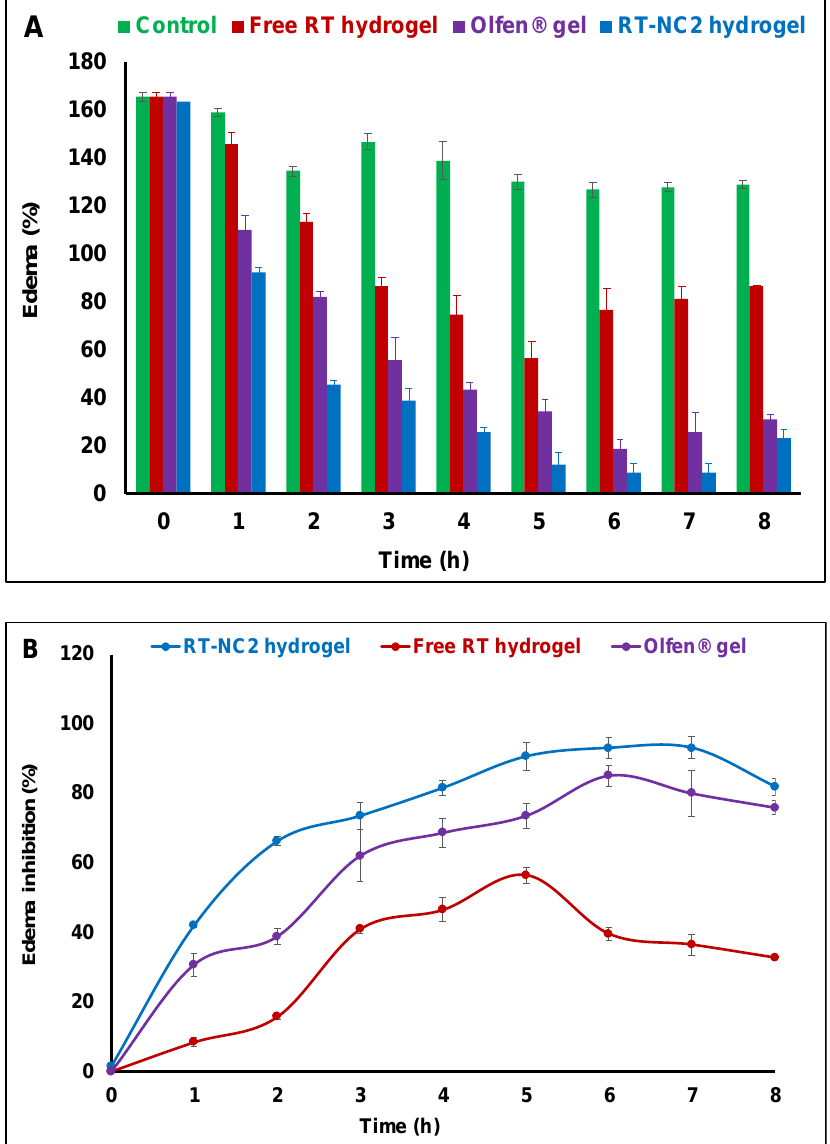
Figure 8. ( A ) Percent of paw edema as a function of time in rats after treatment with the selected rutin nanocrystal formulation (RT-NC2) hydrogel in comparison to rats treated with free RT hydrogel, Olfen ® gel, and untreated rats. ( B ) Percent of paw edema inhibition as a function of time in rats after treatment with the selected rutin nanocrystal formulation (RT-NC2) hydrogel in comparison to rats treated with free RT hydrogel and commercial Olfen ® gel.